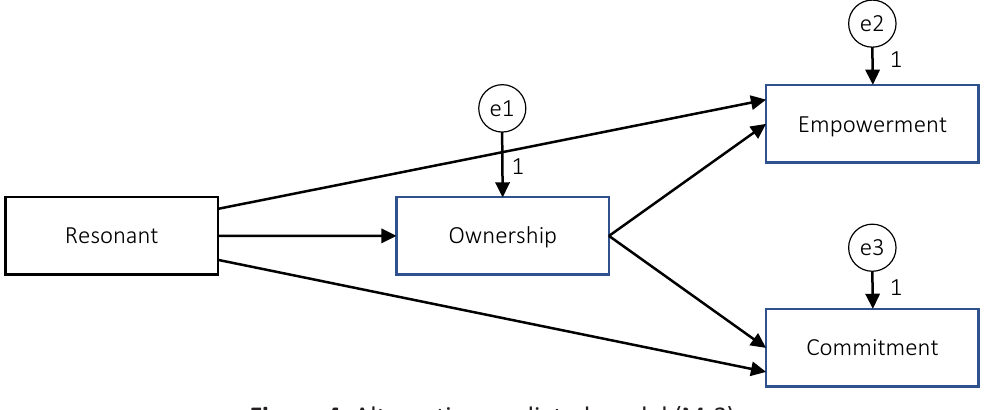
Figure 4. Alternative mediated model